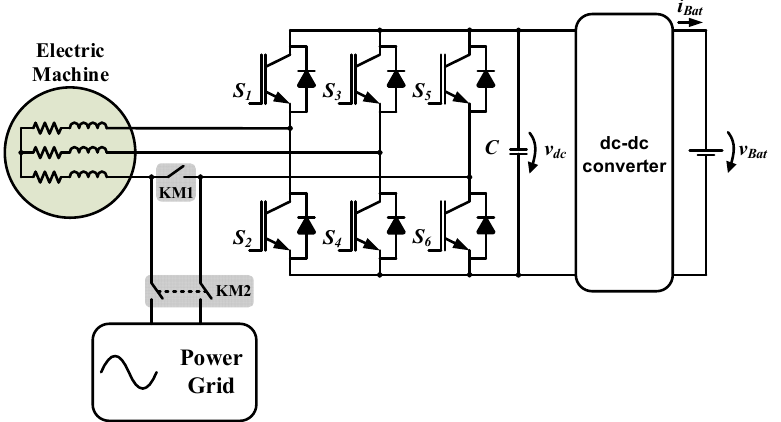
Figure 1. Non-isolated, single-phase unified power converter topology based on an electric machine without neutral point access [2].